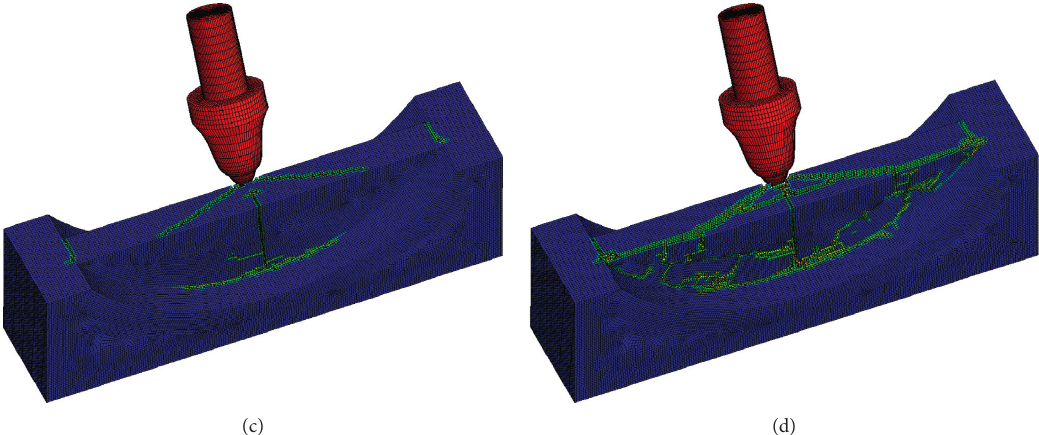
Figure 5: The process of conical pick cutting arc rock plate. (a) Conical pick contacting the arc rock plate. (b) Main cracks generation. (c) Propagation into branch cracks. (d) Cracks connection and fragments